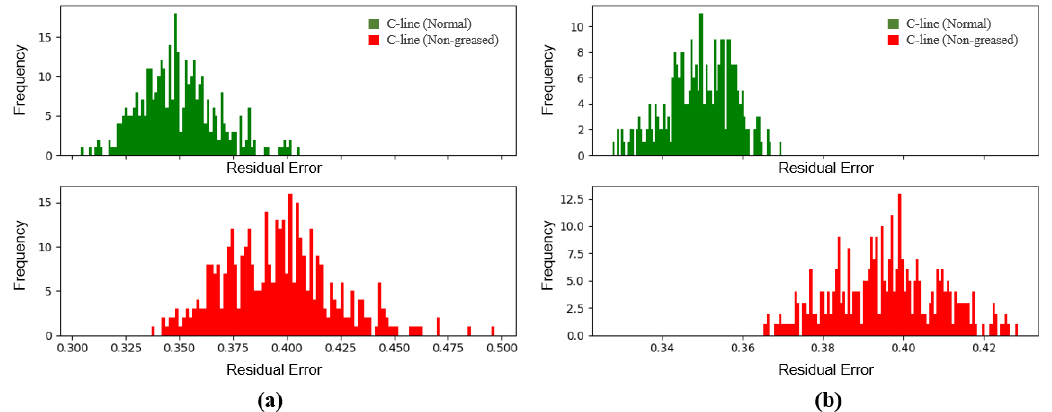
Figure 11. Histogram of the average residual errors between the input data and its reconstruction by the auto-encoder: ( a ) the average error of single samples; ( b ) the average error of 20 samples. Note that abnormal data shown above represent the non-greased C-line.